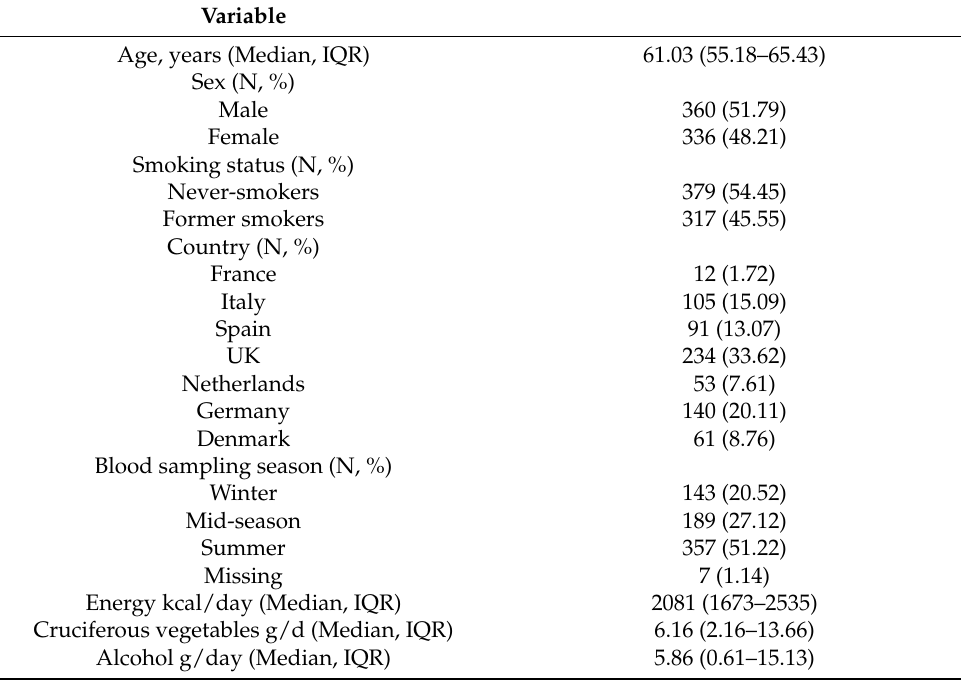
Table 1. Demographic characteristics of the Gen-Air